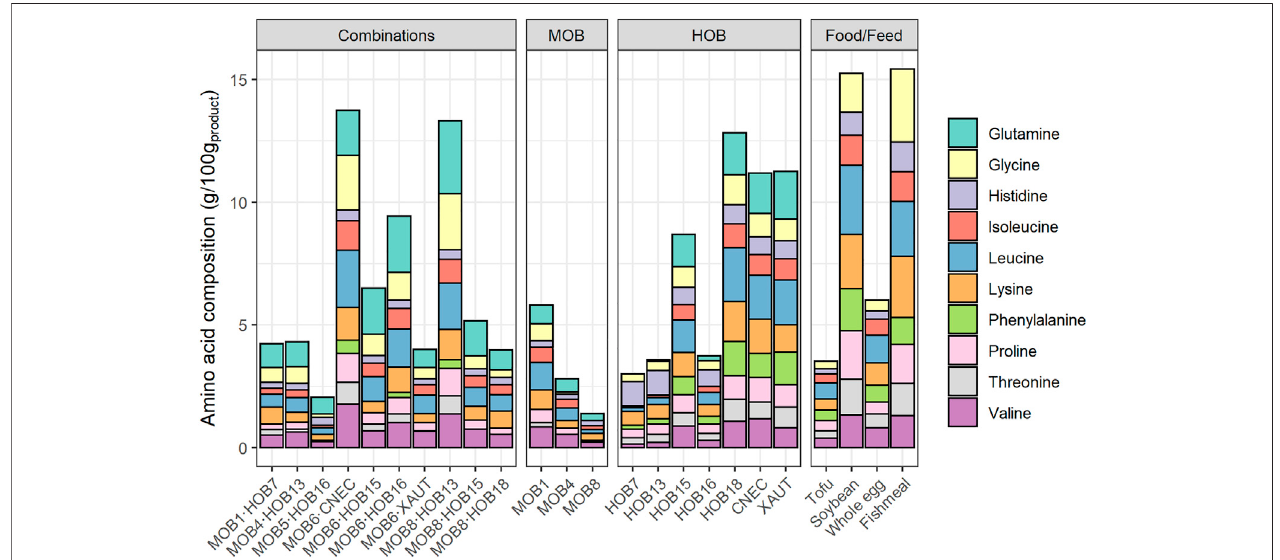
FIGURE 5 | Composition of essential and conditionally essential amino acids in the biomass of the combined methane oxidizing bacteria (MOB) and hydrogen oxidizing bacteria (HOB) cultures as well as individual MOB and HOB strains. The amino acid content is presented in g/100g product , taking into account 5% of moisture (Chemical Composition 1-Unibio, 2021). The amino acid composition of common food and feed ingredients are presented for comparison (in g/100g product ). Essential amino acids: histidine, lysine, phenylalanine, threonine, valine, leucine, isoleucine; Conditionally essential amino acids: glutamine, glycine, proline. Methionine, cysteine, tyrosine, and tryptophan are not included in this graph, since they are (partially) destroyed during acid hydrolysis. MOB 5 and MOB 6 were not included due to poor data quality. The glutamine content of the food and feed ingredients was not reported in the respective references. The full dataset can be found in the Supplementary Tables S6, S7